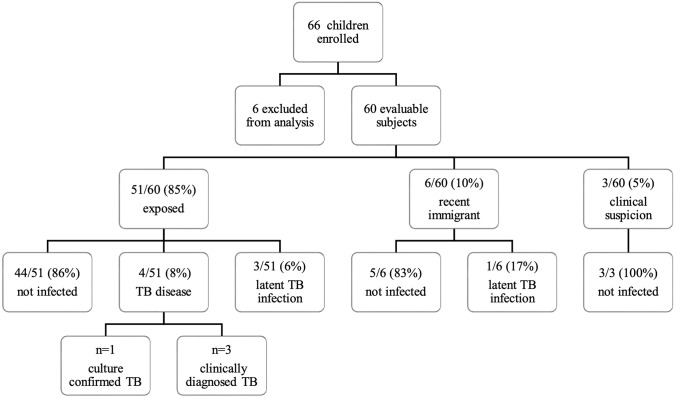
Flowchart of inclusion and classification. Sixty-six children were enrolled in the study. Six children were excluded from analysis: one child had a confirmed Mycobacterium avium infection, one child's QFT sample was lost during transport, one child's QFT was not done simultaneously with the TST, and three children were lost during follow-up. Among the 60 remaining children, tests were requested in 51 children after exposition to a contagious TB case, in six due to recent immigration and in three based on a clinical suspicion of TB disease (no known contact exposure). QFT, QuantiFERON®-TB gold in-tube test; TB, tuberculosis; TST, tuberculin skin test.